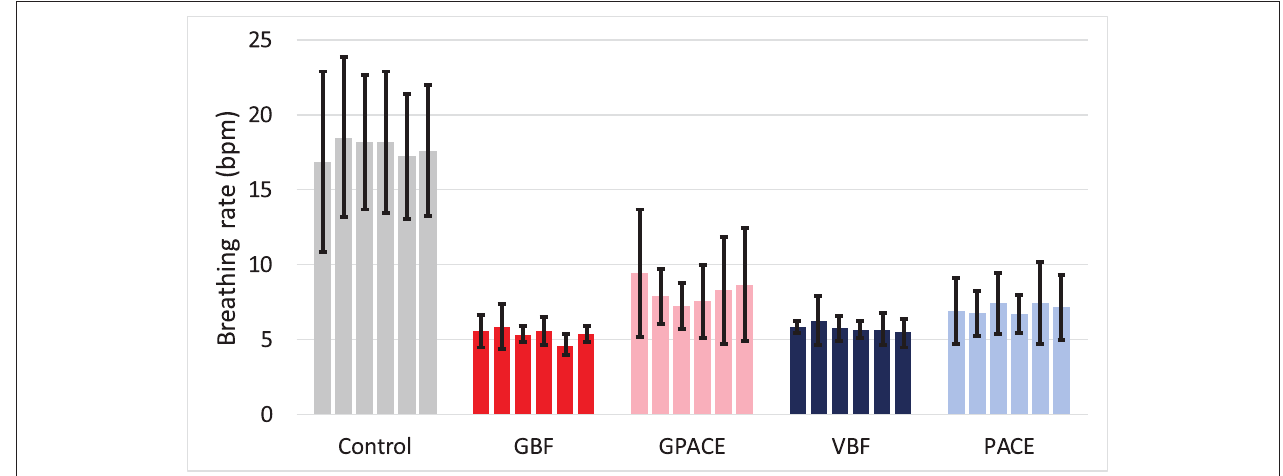
FIGURE 6 | Average breathing rate trend during the six-treatment session for control and experimental groups.